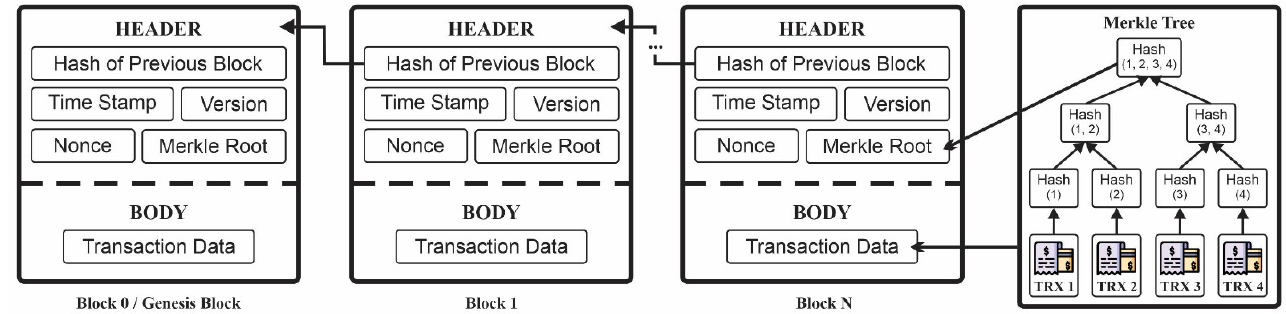
Figure 1. Block structure of a blockchain.